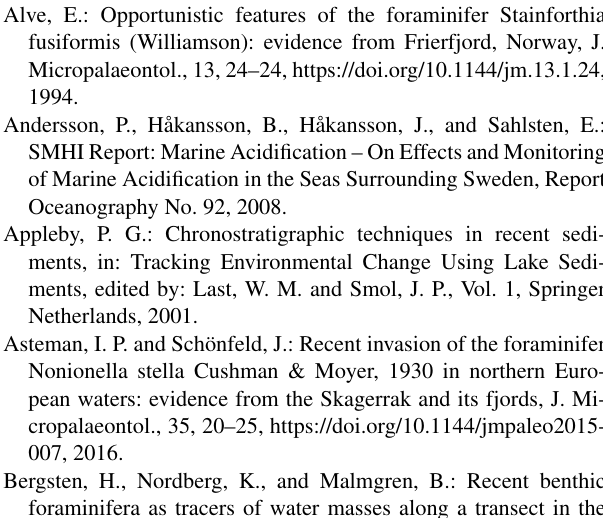
Supplement. Figure S1, with time series of salinity, temperature, and dissolved oxygen concentration at the bottom water of the Öre- sund, and Table S1, with total foraminiferal faunas normalized